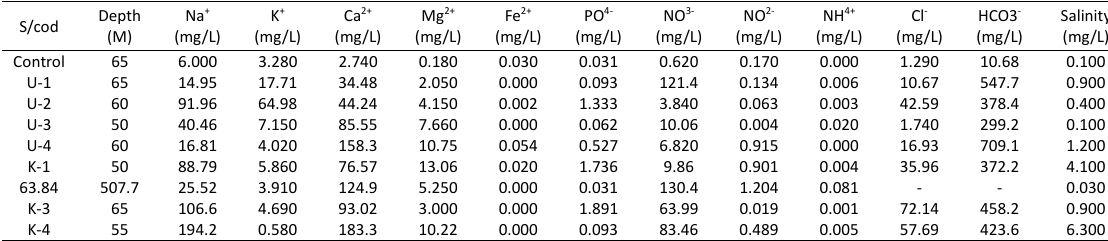
Table 6: Chemical parameters in dry season (mg/L)